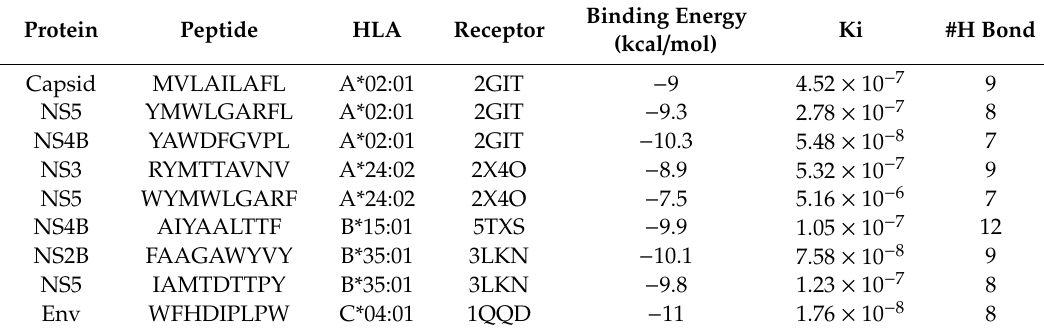
Table 4. Summary of docking results of epitope with MHC-I.